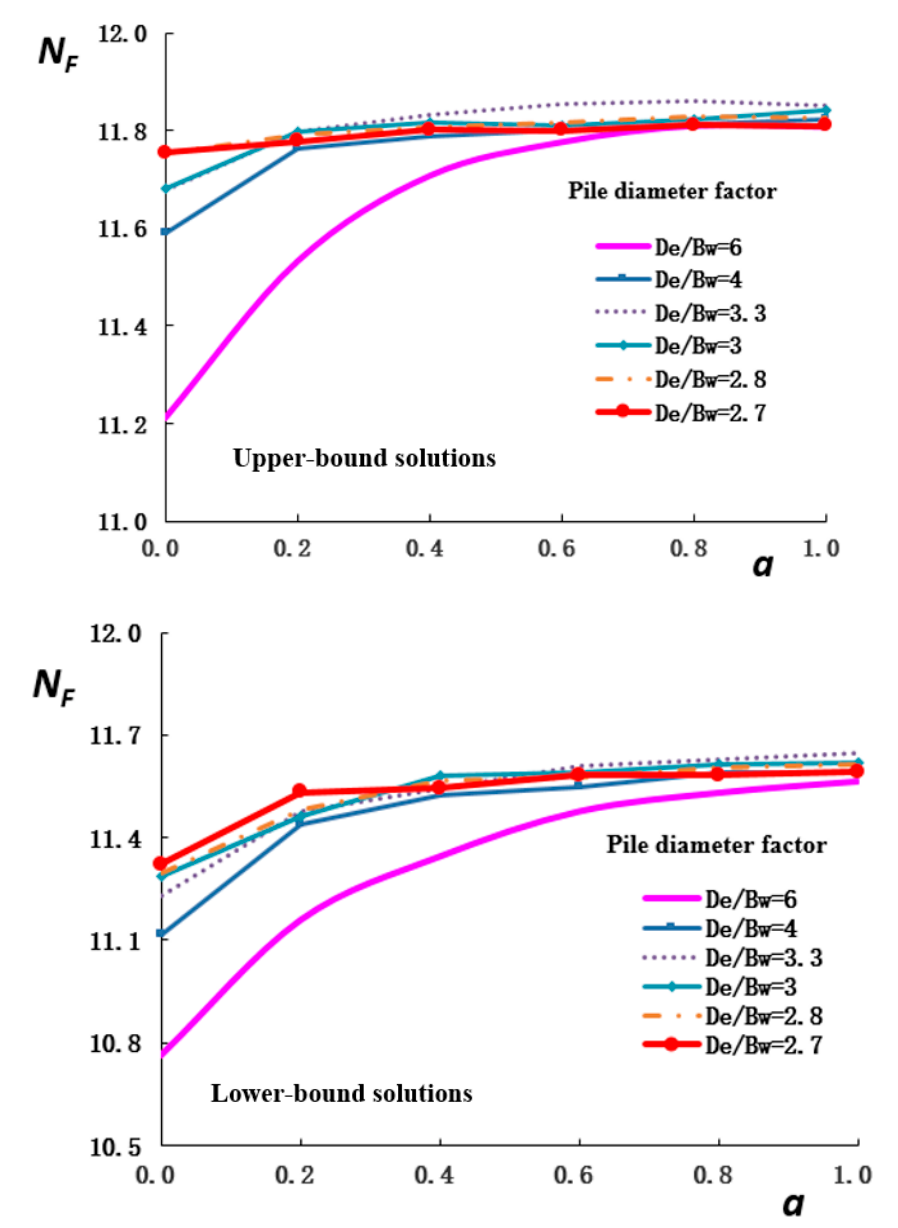
Figure 13. Relationship between the normalized ultimate lateral capacity ( N F ) of the four-wing pile and the pile–soil interaction coefficient ( α ) when lateral-load angle β = 0. ( Top ) Upper-bound and ( Bottom ) lower-bound solutions from limit analysis with different wing-to-diameter ratios. ( D e : effective diameter; B w : wing width.).